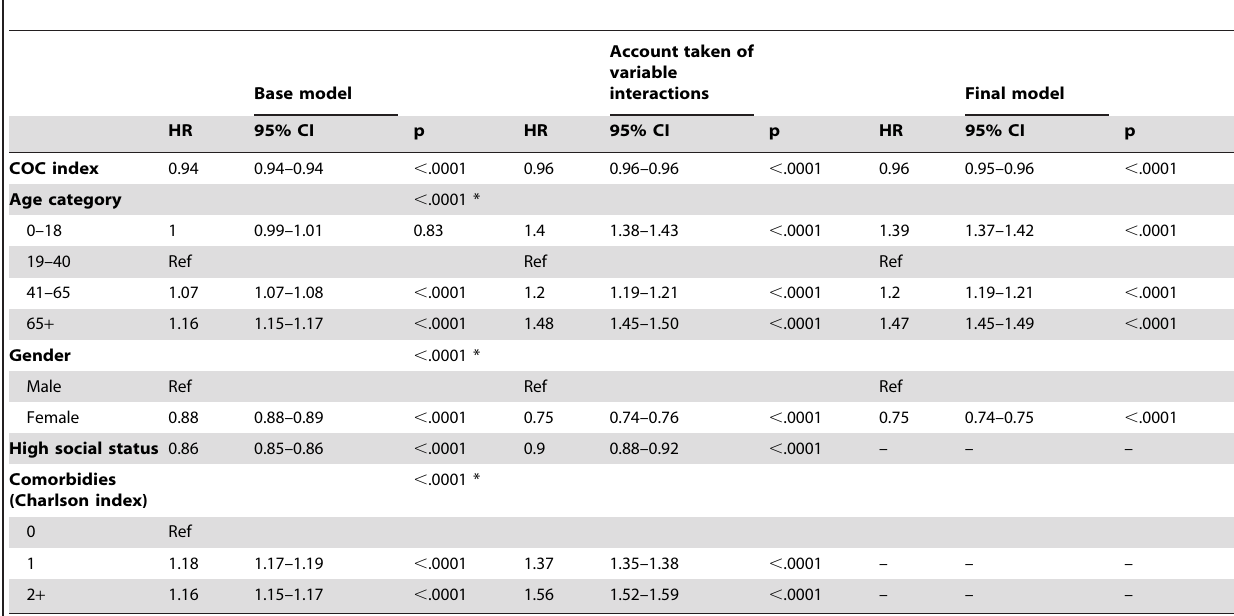
Table 3. Hazard ratios recorded for variables included in the survival regression analysis in the base model, after taking account of variable interactions, and in the final model stratified by social status and